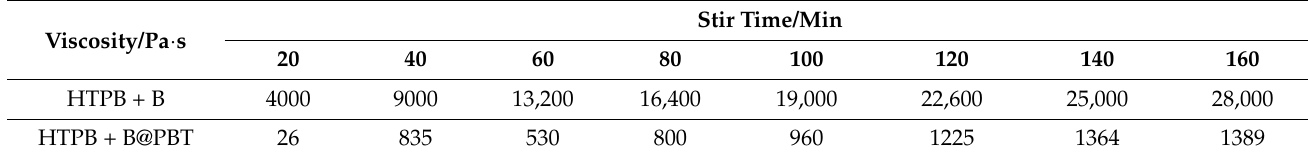
Table 2. The changes in viscosity with time in the mixing process of B and B@PBT with HTPB [80]. Stir Viscosity/Pa · s